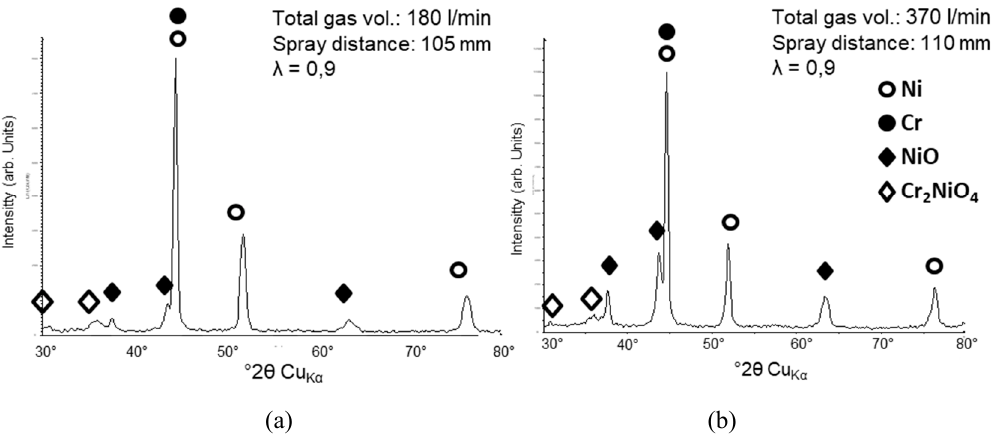
Figure 9. Comparison of XRD spectra for NiCr coatings sprayed with two different total gas flow amounts (180 vs. 370 L/min) as noted in the graph. λ was kept constant, and the spray distance differs slightly. ♦ symbols highlight the most prominent oxide peaks that were identified according to Figure 8.